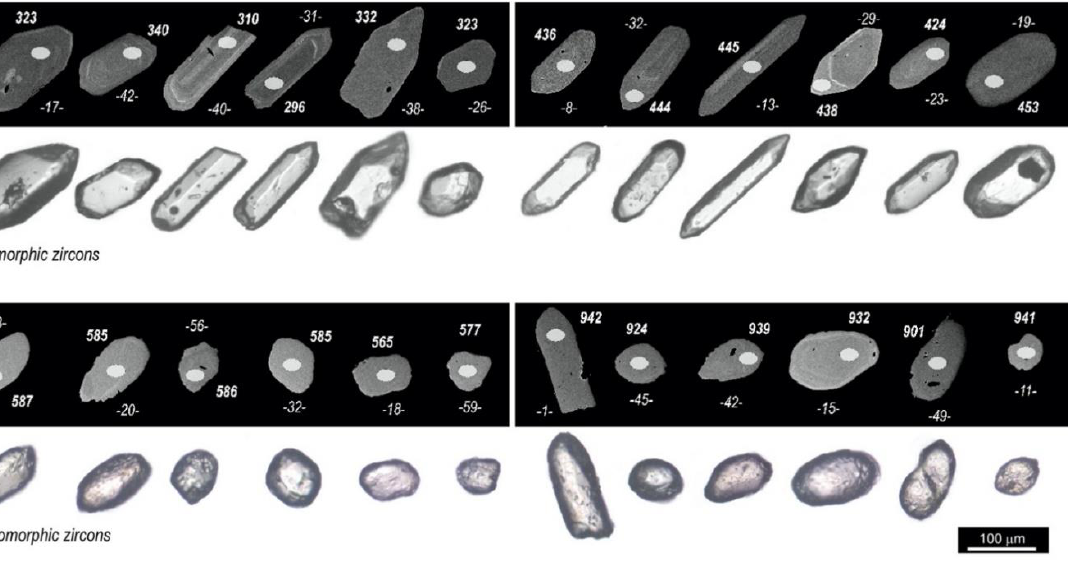
Figure 10. BSE images and optical photomicrographs of analysed zircons from tb-18-06 sample (quartzite). Ellipses mark analytical spot locations and the text shows spot names (italics) and 208 Pb/ 236 U age in Ma (bold).